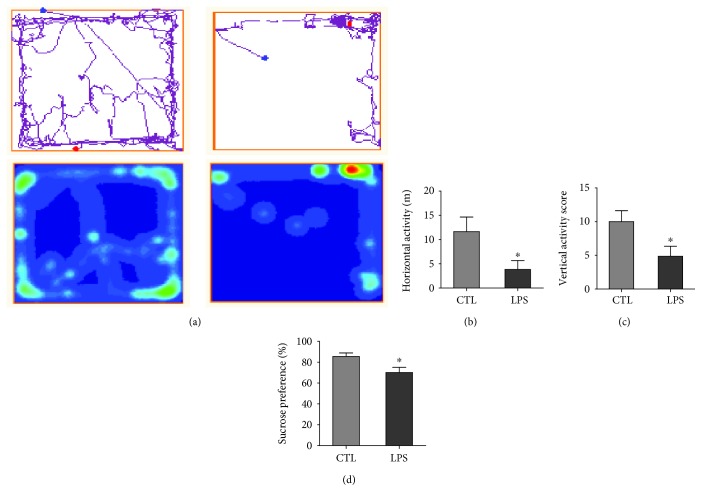
LPS group rats exhibited depressive-like behaviors in SPT and OFT compared with the CTL group. (a) The locomotion track of the CTL and LPS groups. The red area represented the longer residence of the rats, while the green area represents the shorter residence and the blue area represents the least residence of rats. (b, c) LPS group rats showed a lower activity score in OFT compared to the CTL group, horizontal activity score in OFT: ∗P < 0.05, t(10) = 2.202, P = 0.0479; vertical activity score in OFT: ∗P < 0.05, t(10) = 2.317, P = 0.039. (d) LPS group rats showed a decreased consumption of sucrose in SPT compared to the CTL group, ∗∗P < 0.01, t(10) = 2.611, P = 0.0228. CTL: n = 6, LPS: n = 6. Values are expressed as mean ± SEM. Independent t-test results are shown in this figure.